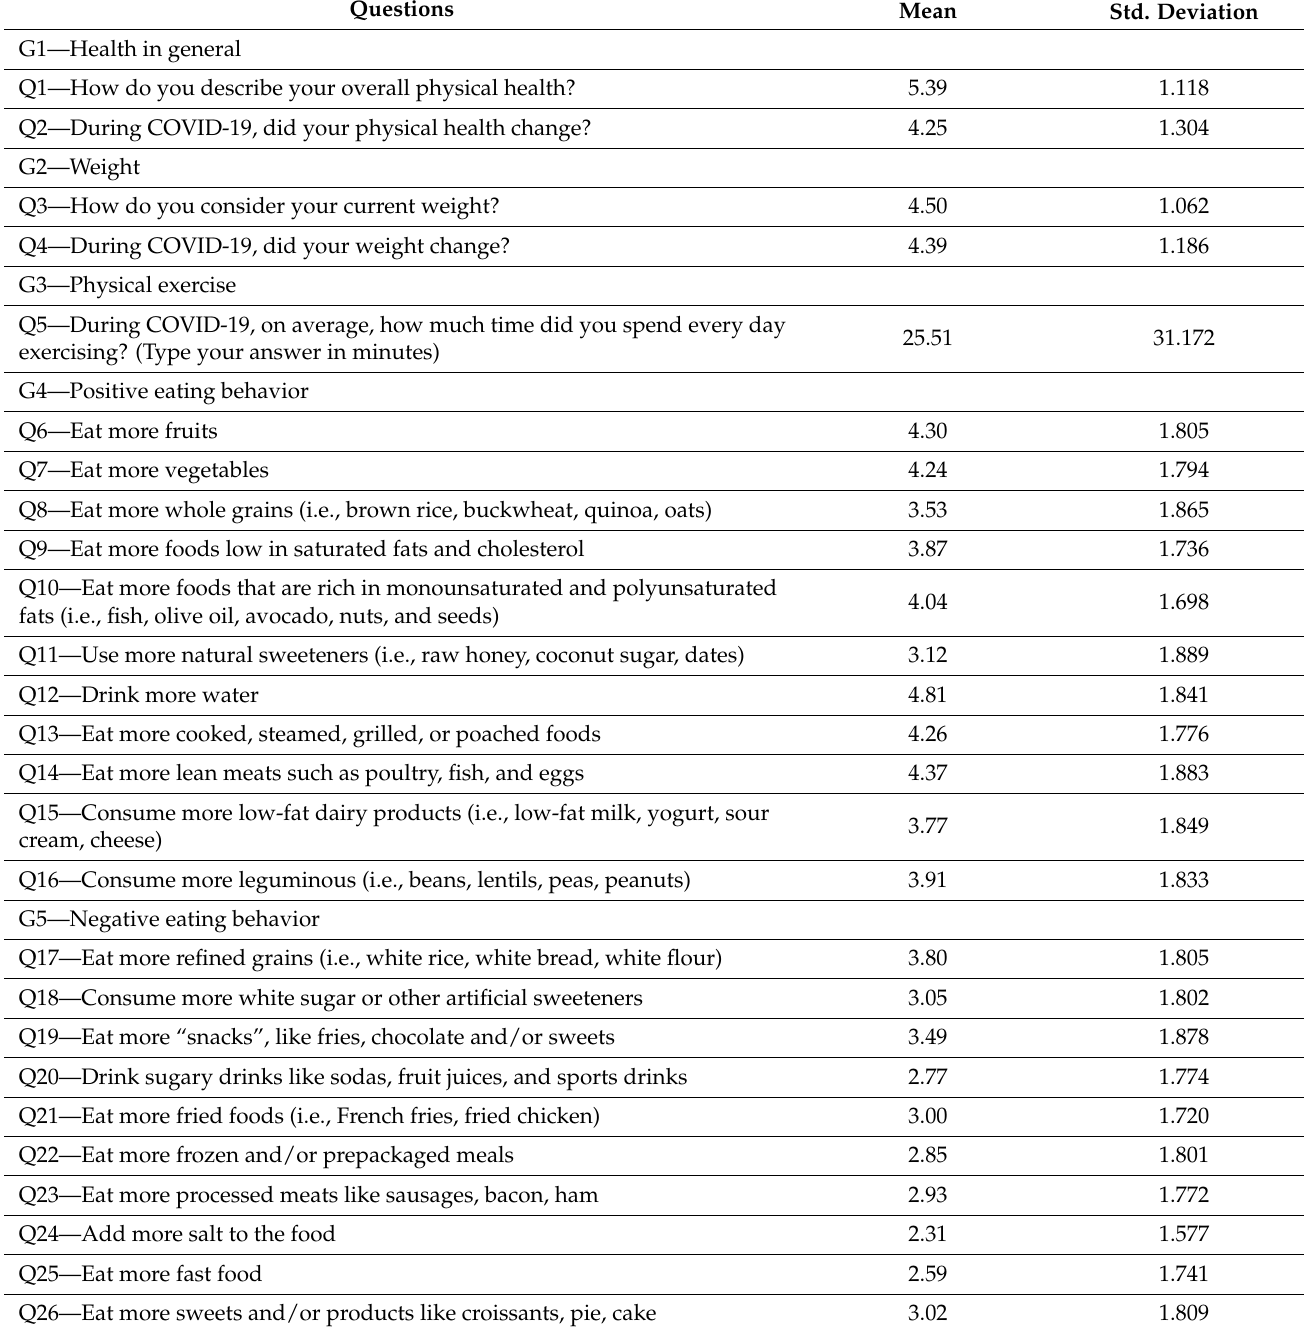
Table 2. Mean and standard deviation of responses to questions from groups G1 to